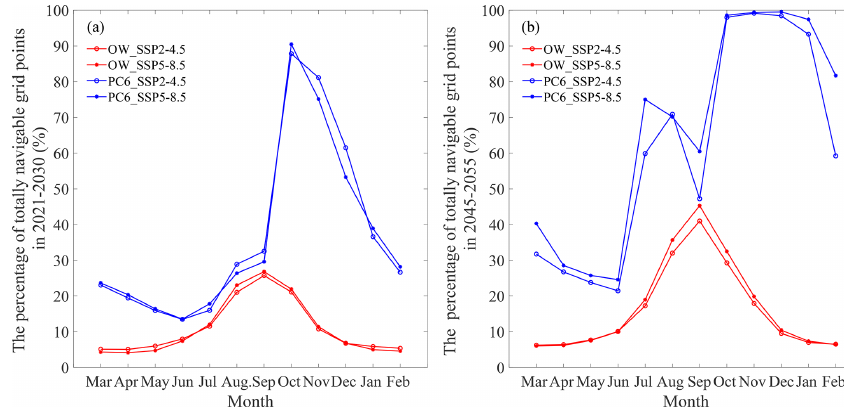
Figure 7. The percentage of totally navigable grid cells for OW ships and PC6 ships under SSP2-4.5 and